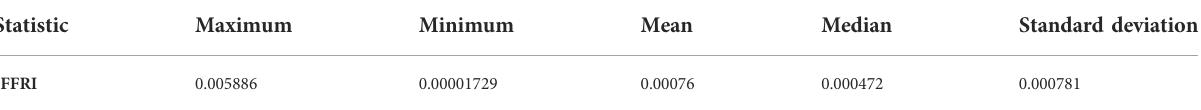
TABLE 5 IFFRI descriptive statistics.